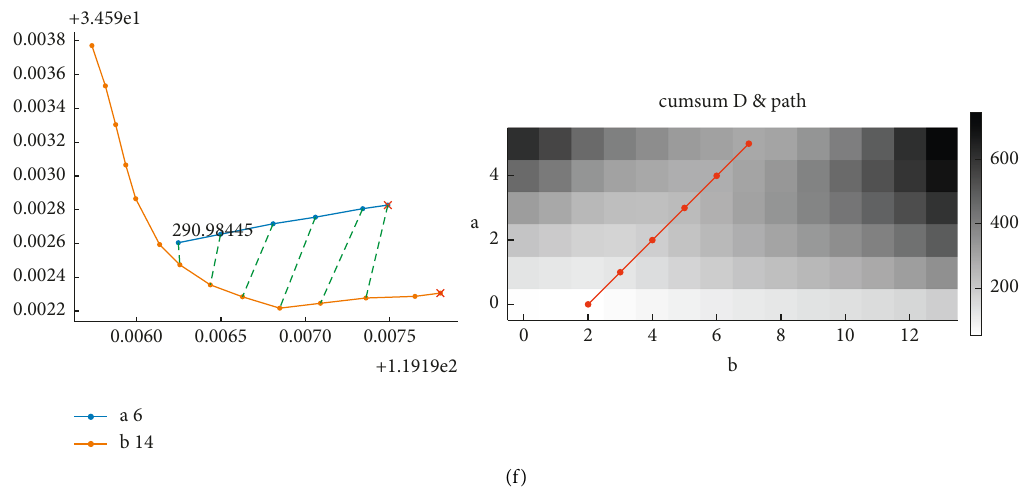
Figure 6: Asymmetric generalized DTW for boundary condition. (a) OBA. (b) OBB. (c) OEA. (d) OEB. (e) OBEA. (f) OBEB.